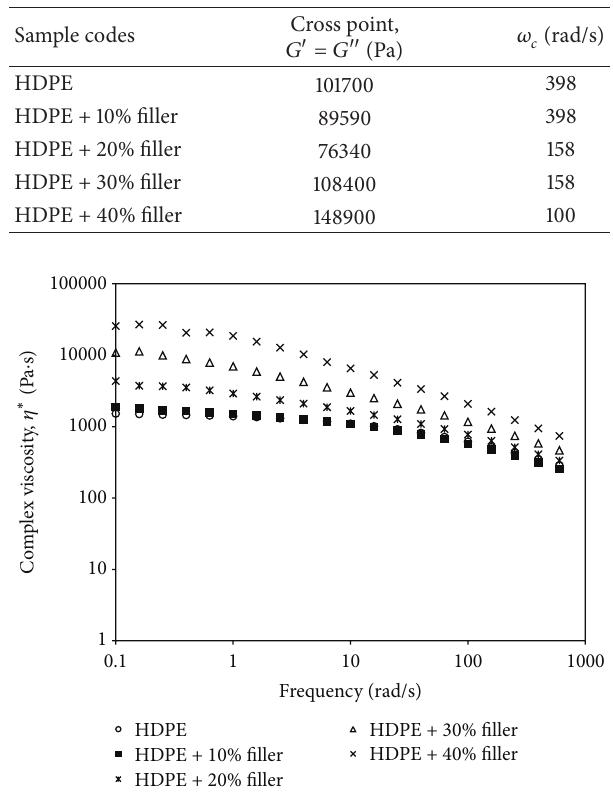
Figure 4: Variation of the complex shear viscosity as a function of frequency for neat renewable HDPE and its composites containing different wt% of sponge gourd filler.